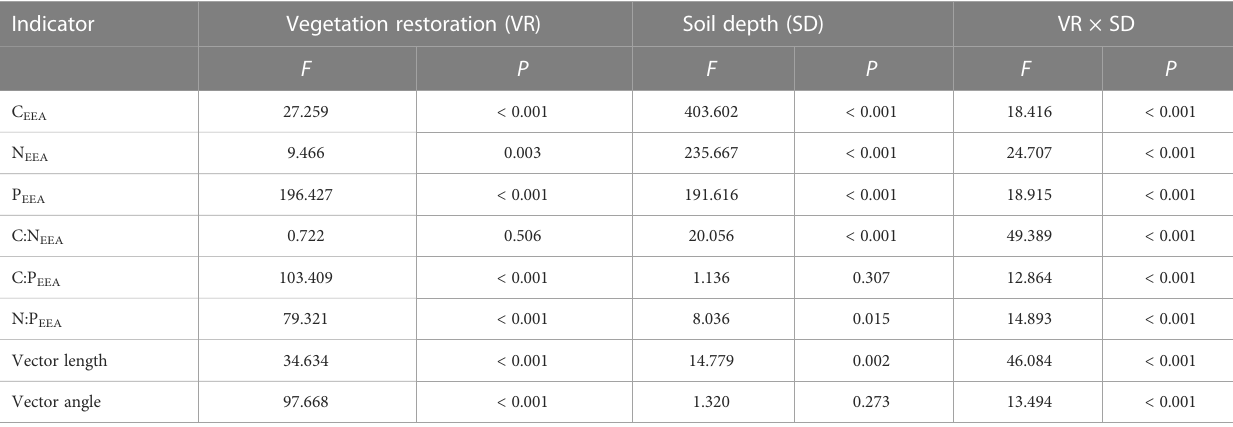
TABLE 2 ANOVA results for soil EEA and EES as affected by vegetation restoration (VR), soil depth (SD), and their interactions (VR × SD).